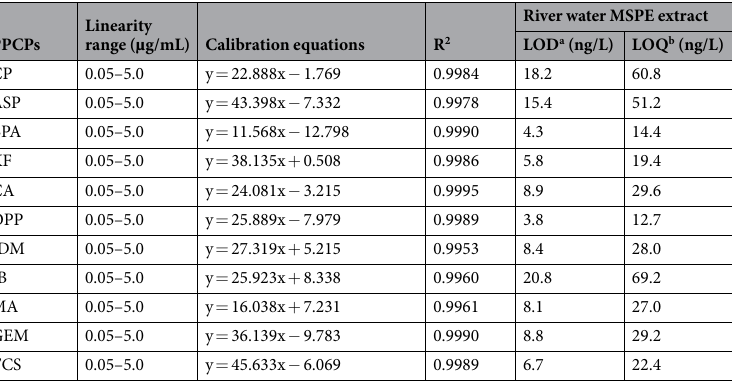
Table 2. Analysis performance for the determination of eleven target compounds in environmental water using MSPE-HPLC. a Detection limits are calculated using S/N = 3. b Quantification limits are calculated using S/N = 10.